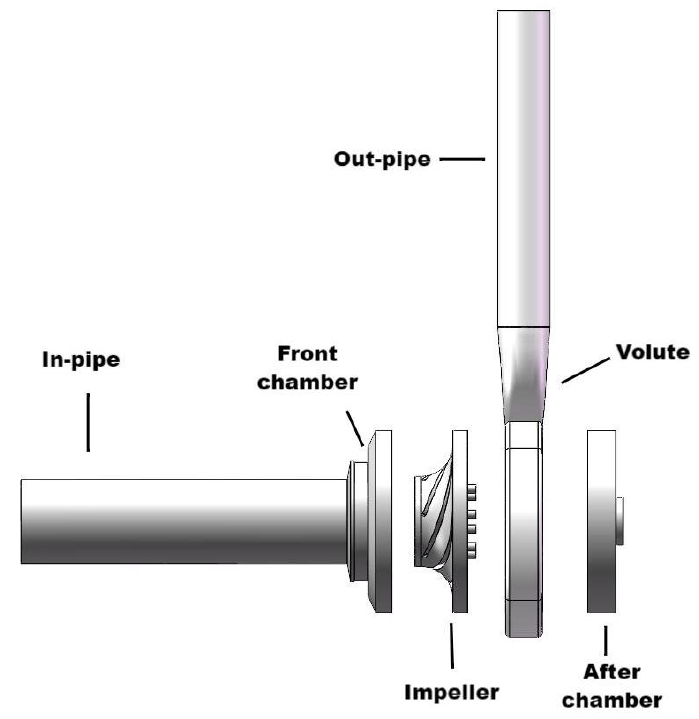
Figure 1. Schematic diagram of the simulation fluid domain of the pump. Table 1. Basic parameters of the centrifugal pump.